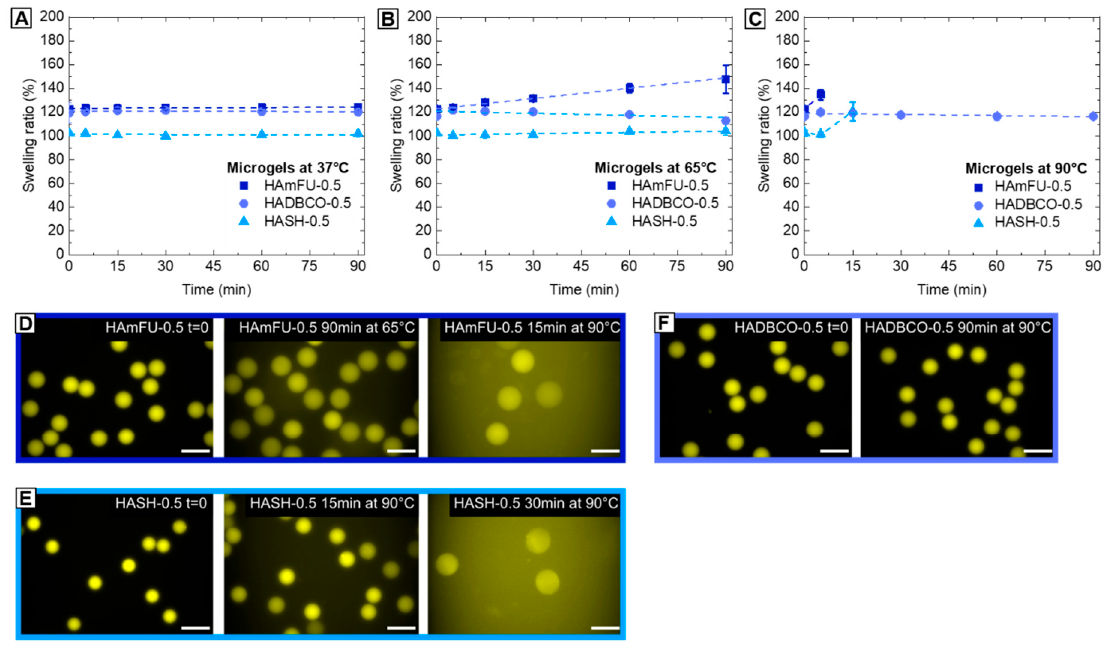
Figure 5. Thermostability studies of HA-microgels crosslinked with 0.5 Eq homobifunctional PEGs. ( A – C ) Microgels are heated to (A) 37 °C, (B) 65 °C, (C) 90 °C, respectively, and imaged via fluorescence microscopy over time to determine the swelling ratio and tendency of degradation (n = 50; mean ± SD). ( D – F ) Exemplary fluorescence microscope images of (D) HAmFU − 0.5, (E) HASH − 0.5, and (F) HADBCO − 0.5 microgels comparing the initial state (t = 0) to microgels at selected time points and temperatures, respectively. The scale bars denote 50 µm.